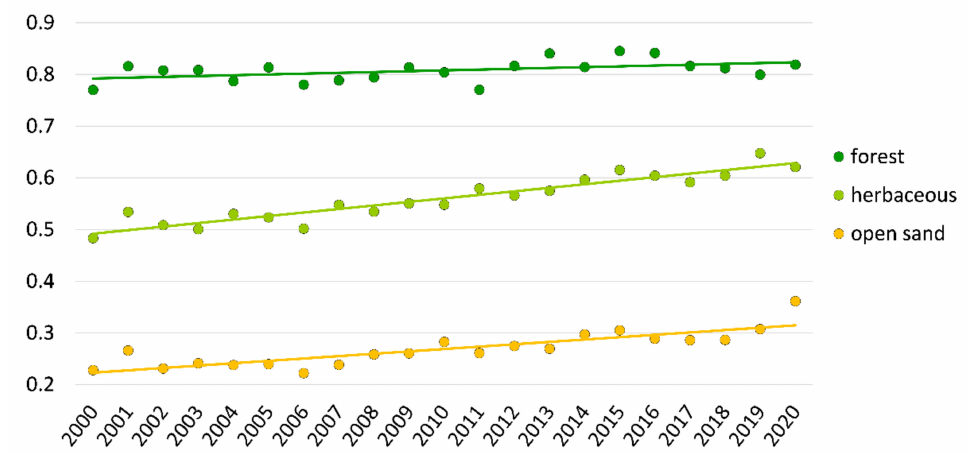
Figure 5. Average annual NDVI in forest, herbaceous, and open-sand ecosystems of the Curonian Spit during the growing seasons from 2000 to 2020. Table 3. Sen’s slope values, NDVI monthly averages 2000–2020. May June July August September Forest 0.0024 ** 0.0030 ** − 0.0006 * 0.0008 * 0.0020 * 0.0015 ** Herbaceous 0.0075 *** 0.0058